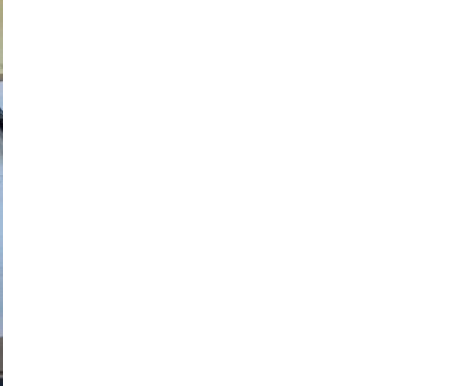
Figure 5. Calculation of the total leaf area of ice plants ( M. crystallinum ) using the curvimeter method.